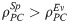
Detailed spiking LIF model confirms the results from analytic rate model.Schematic of the LIF model with 2 sets of recurrently coupled E and I cells. There are 12 types of synaptic connections. (A) Pairwise correlations in PC, spontaneous vs. evoked: ρPCSp>ρPCEv. (B) Variability (Fano factor) in PC, spontaneous vs evoked: FFPCSp>FFPCEv. (C) Correlations in the spontaneous state, PC vs. OB: ρPCSp>ρOBSp. (D) Correlations in the evoked state, PC vs. OB: ρPCEv<ρOBEv. (E) Variability (Fano factor) in the spontaneous state, PC vs. OB: FFPCSp>FFOBSp. (F) Variability (Fano factor) in the evoked state, PC vs. OB: VarPCEv<VarOBEv in evoked state. (G) Covariances in the evoked state, PC vs. OB: CovPCEv<CovOBEv. (H) Variability (spike count variance) in OB, spontaneous vs. evoked: VarOBSp<VarOBEv. The curves show the average statistics over all NOB/PC cells or over a large random sample of all possible pairs. See Materials and methods for model details, and Table 4 and Eq 5 for parameter values.